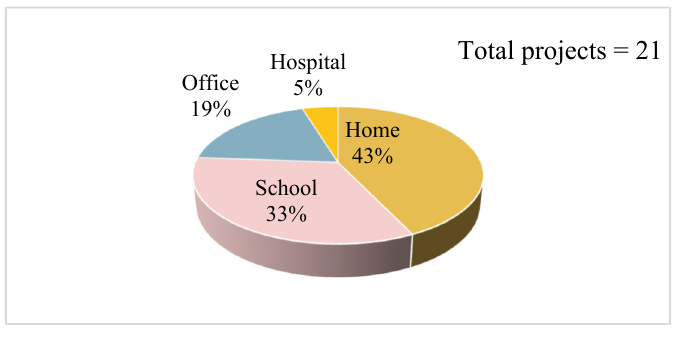
Figure 4. Percentage of each building category.